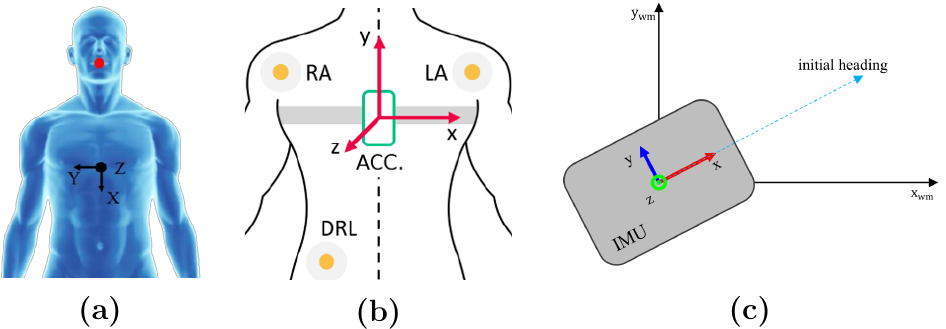
Figure 5. Examples of IMU coordinates alignment on body taken from the referenced studies. ( a , b ): IMU acceleration coordinates with respect to body axes for SCG, respectively, from [19,29]. ( c ): Calibration of the IMU pose with initial heading of the subject within the world map frame for PDR